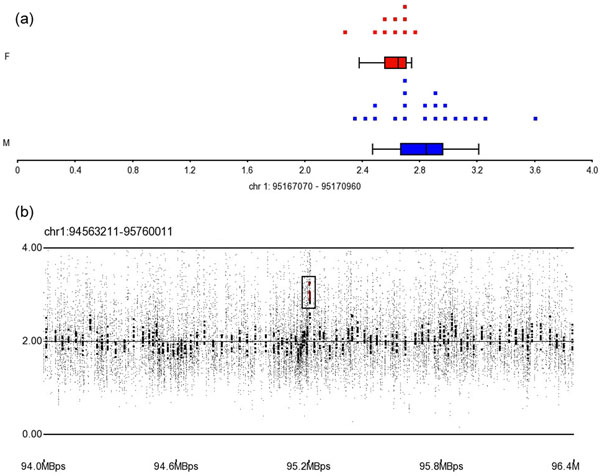
The CN state and SNP array profile graph of gain CNV region on lp21.3. (a) The distribution of CNs in the gain CNV region on 1p21.3. Blue and red dots indicate male and female patients, respectively; (b) SNP array profile for part of 1p21.3; the black box marks the location of the gain CNV region.